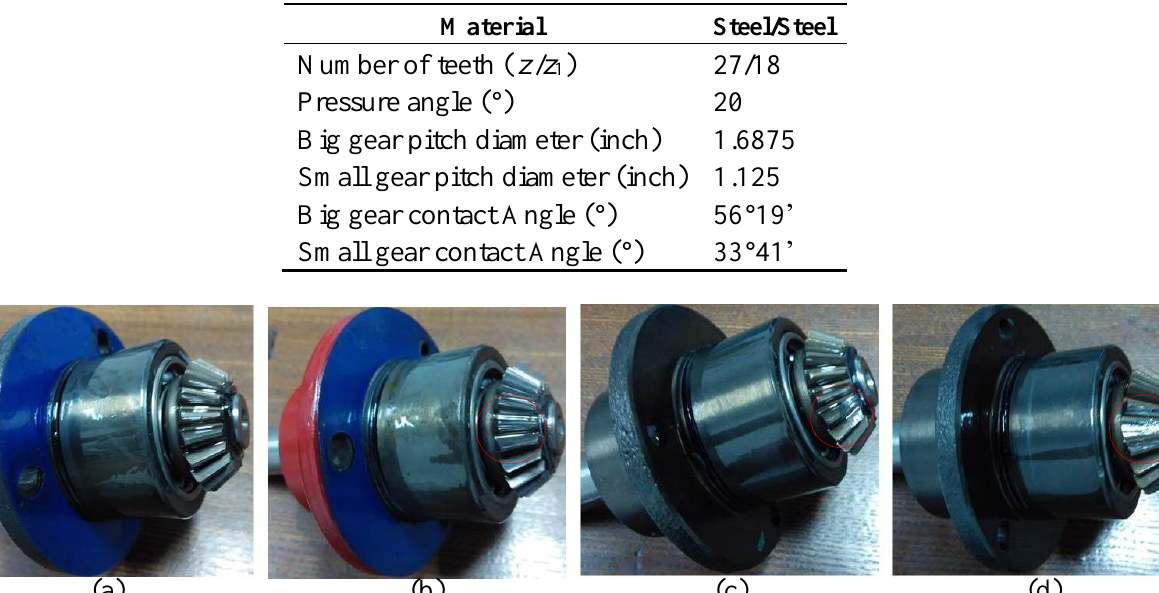
Figure 5. ( a )The experiment rig of gearbox; ( b ) Sketch map of the gearbox. Table 2. Specifications of the bevel gearbox.